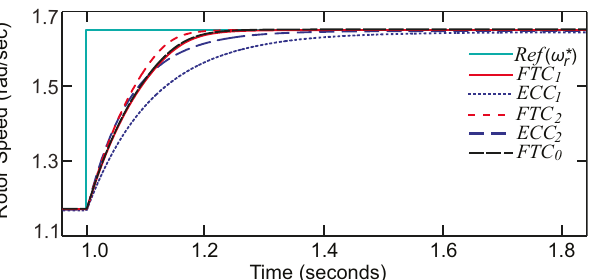
Figure 12. Responses of FTCs and ECCs under nominal and perturbed conditions.